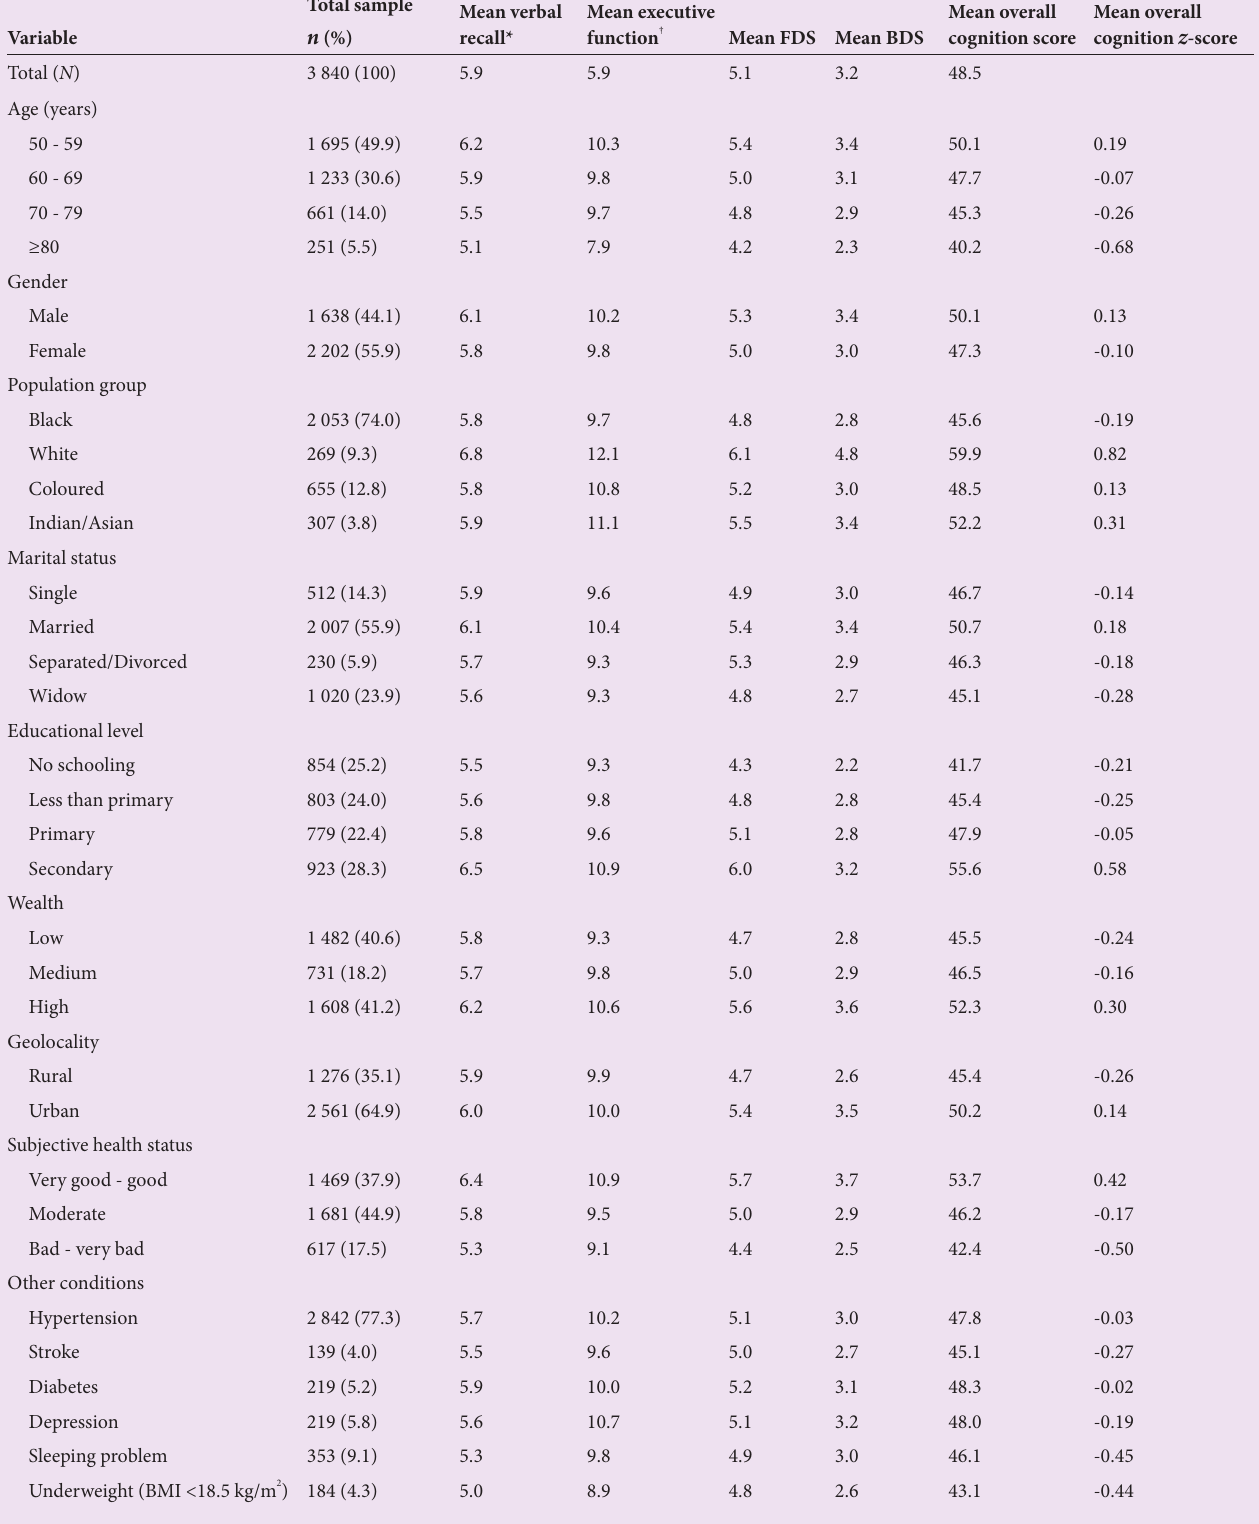
Table 1. Sample characteristics and prevalence of cognitive functioning among older South Africans Variable